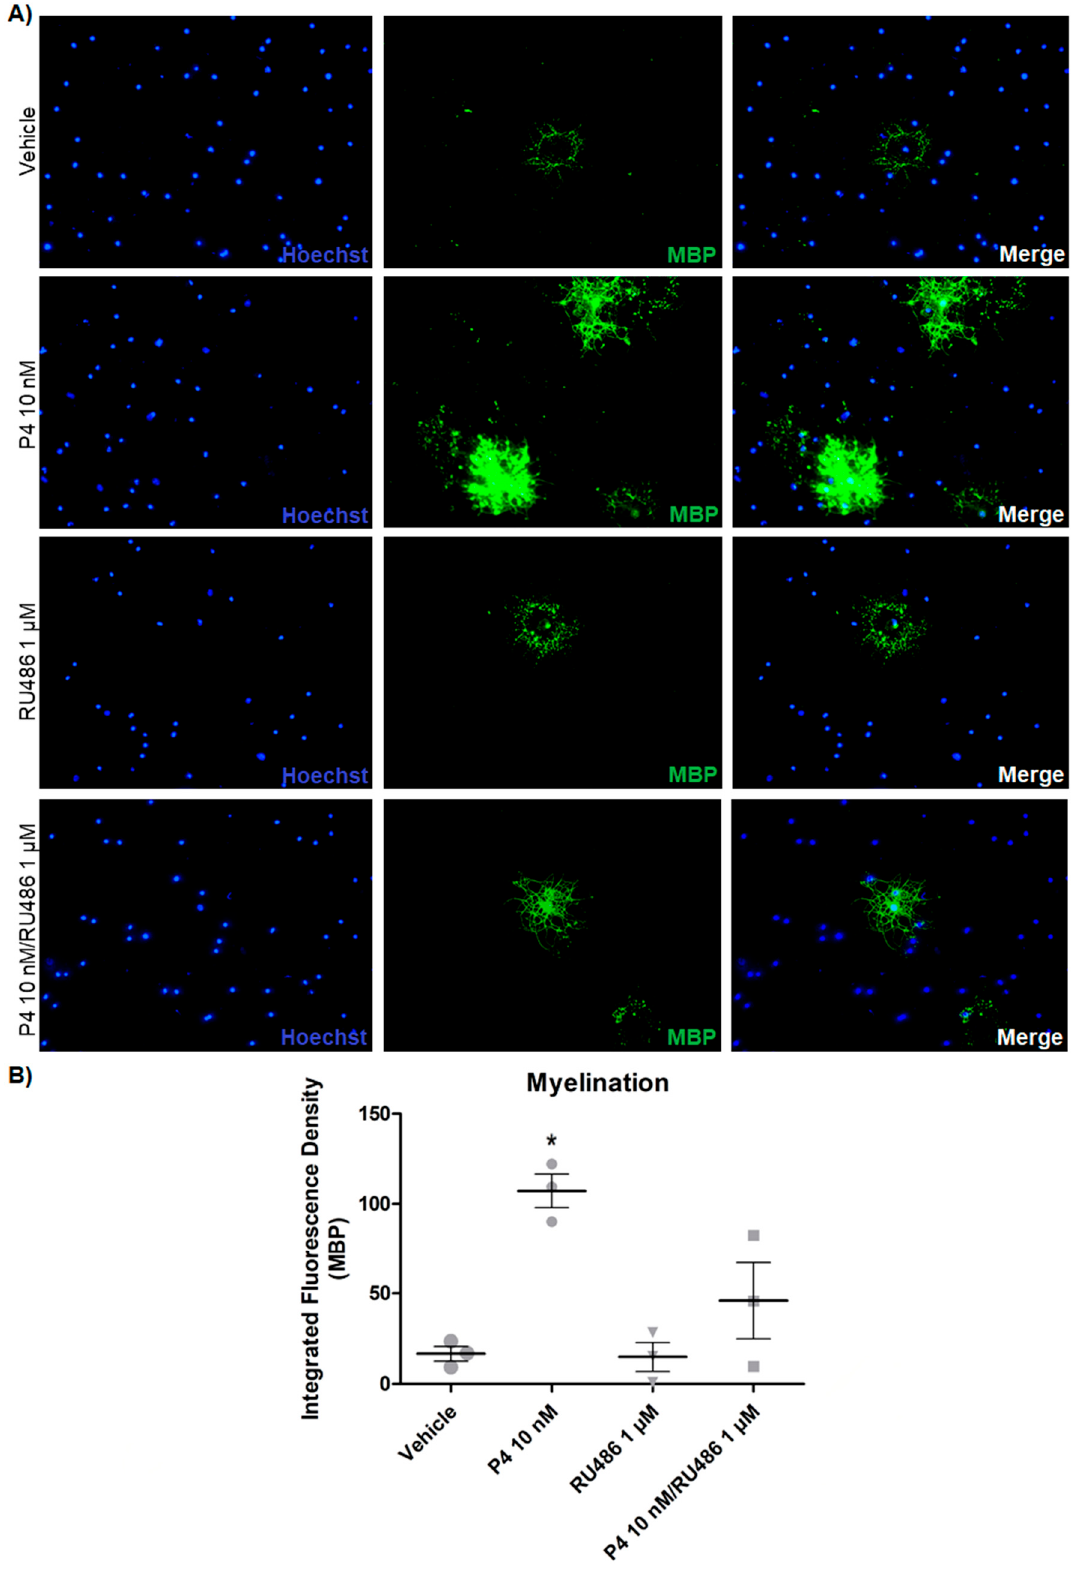
Figure 4. Progesterone increases the potential of myelination of differentiated OPC. ( A ) MBP immunofluorescence in OPC cultured without growth factors and treated for 3 days with P4 (10 nM), RU486 (1 μ M), P4 (10 nM) and RU486 (1 μ M), and vehicle (DMSO 0.01%). ( B ) MBP expression measured as a fluorescence density. Results are expressed as the mean ± S.E.M. n = 3; * p < 0.05 vs. vehicle and RU486.